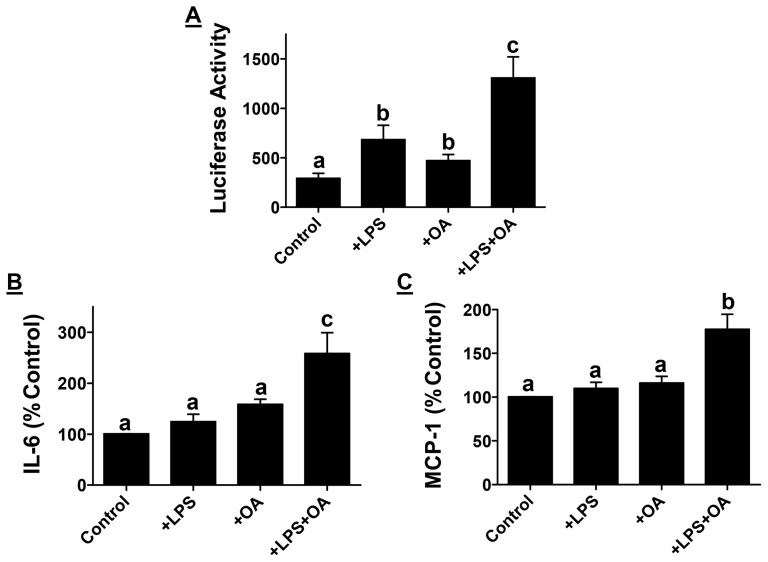
Increased macrophage activation by low dose LPS.
Panel A: Mouse peritoneal macrophages were transduced with AdNF-κB-Luc and treated with LPS (50 pg/ml) or Oleic acid (50 µM) as indicated. Luciferase activity was normalized to cellular protein and data are presented as percent untreated Controls (Mean ± SEM, n = 6). Panel B and C: Conditioned medium was collected after incubation of mouse peritoneal macrophages with LPS with or without oleic acid as indicated and IL-6 and MCP-1 levels were determined by ELISA. Data are expressed as percent of no addition control (Mean ± SEM, n = 6). P<0.0001 by One way ANOVA with Bonferroni post-hoc correction; Dissimilar letters above the bars indicate significant differences between groups (P<0.05).